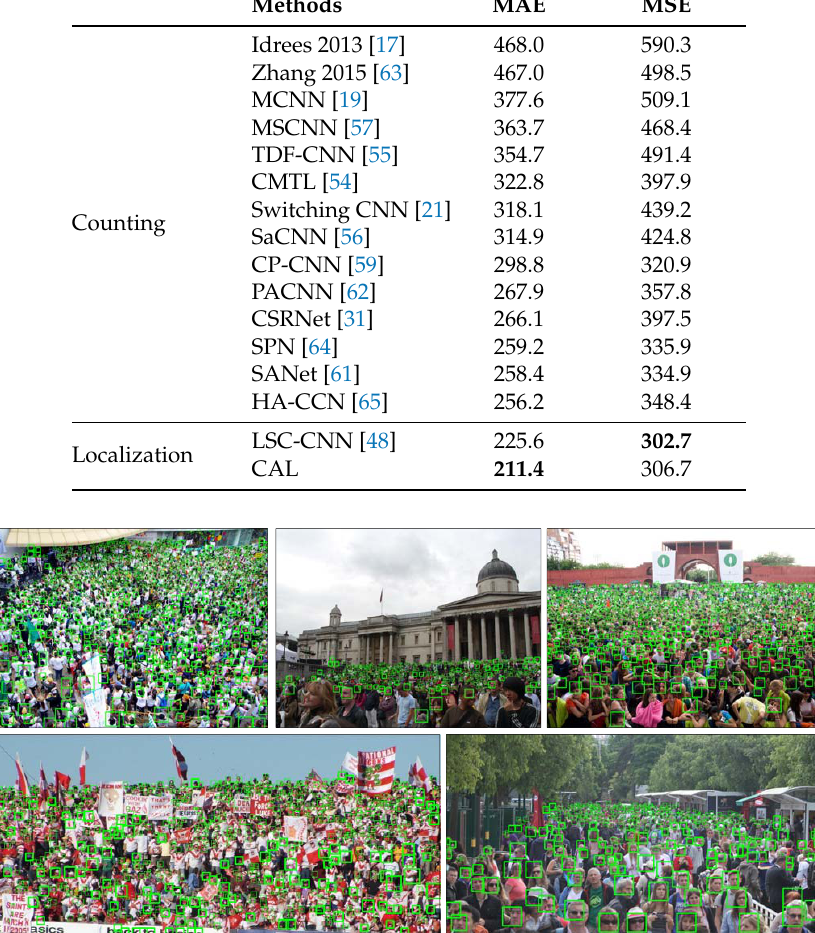
Table 4. The comparison among the state-of-the-arts and our approach in UCF_CC_50. The best result is in bold.